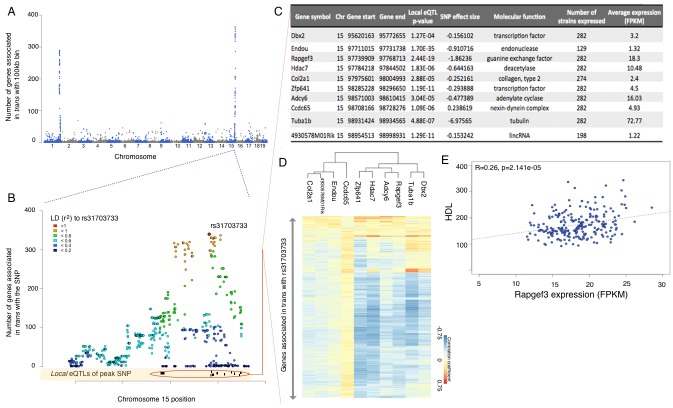
eQTL mapping suggests trans eQTL hotspots in the hypothalamus regulate expression of hundreds of genes.(A) Mouse genome was broken into 100 kb bins. The plot presents genome wide counts of genes which expression is associated with SNPs in that region, in trans. (B) Zoom of trans eQTL locus on chromosome 15. Peak SNP (associated with most genes in trans, rs31703733) is shown in red, color of other SNPs indicates r2 to rs31703733. Lower track shows the 10 genes which expression is associated with rs31703733 locally. C,D,E pertain to the 10 genes associated locally with rs31703733 and therefore potentially mediate the trans effects. (C) Summary table about each gene. (D) Heatmap showing correlation of expression between genes associated with rs31703733 locally, and genes associated with rs31703733 in trans. Color indicates Pearson correlation coefficient. (E) Example correlation between potential regulator (RApgef3) and trait (HDL levels).